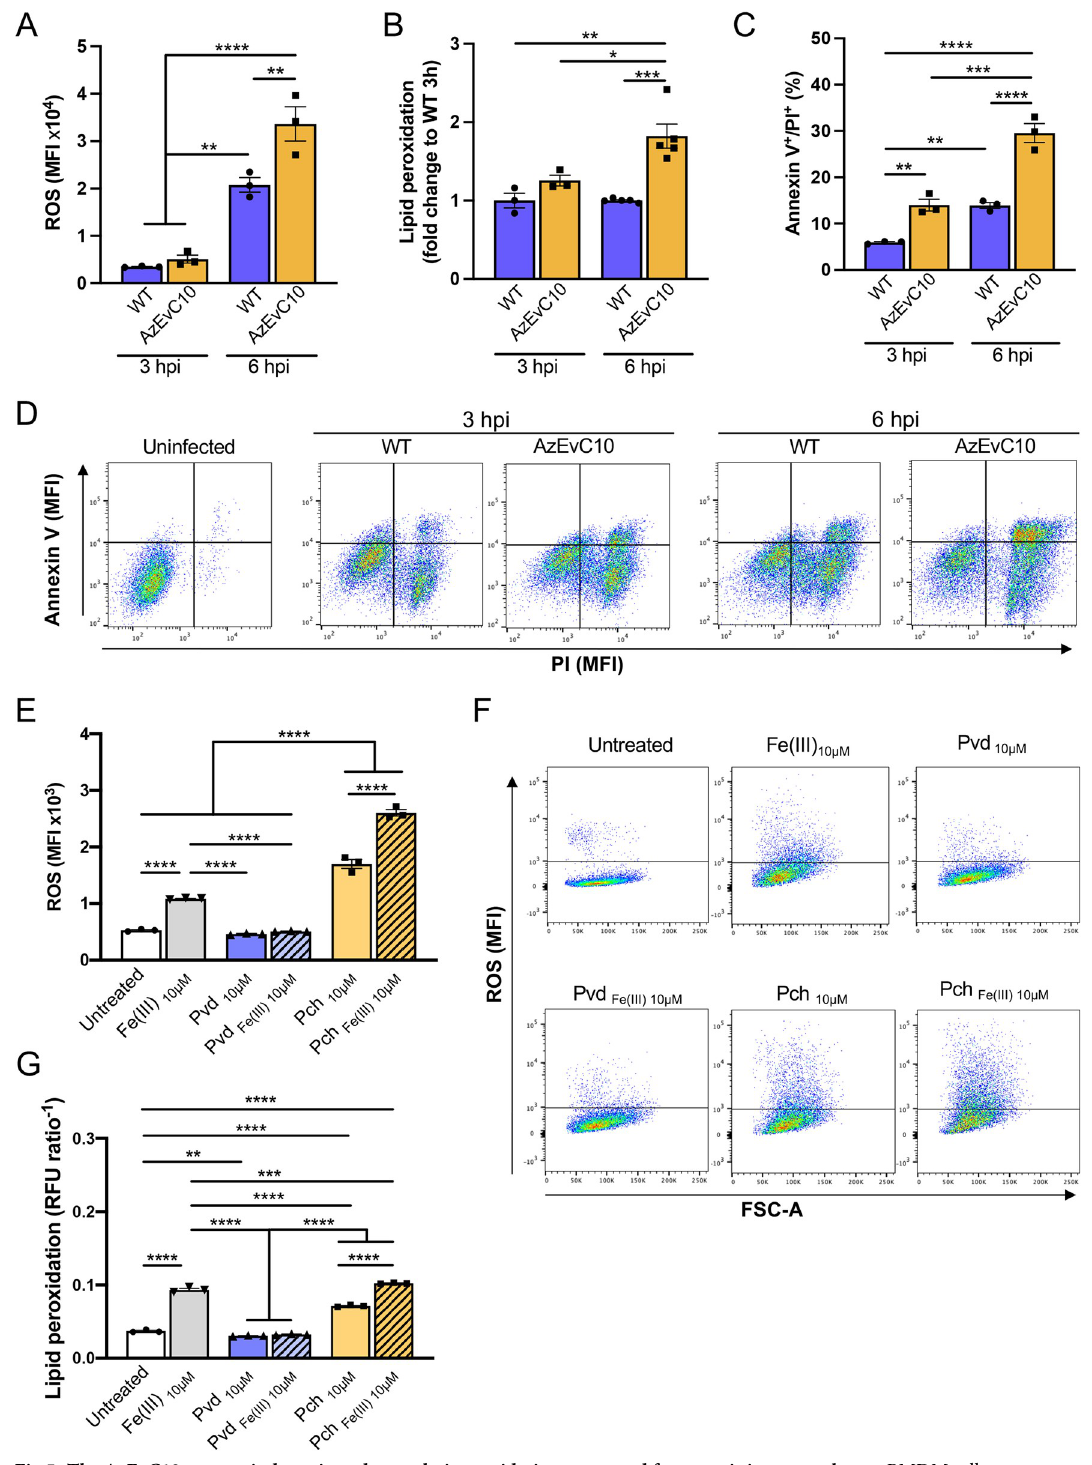
Fig 5. The AzEvC10 mutant induces iron dysregulation, oxidative stress, and ferroptosis in macrophages. BMDM cells were infected with WT PAO1 or AzEvC10 mutant at MOI:100 for 3 h and 6 h. A. Quantification of ROS in infected BMDM by flow cytometry. Quantification is presented in mean fluorescence intensity (MFI). Analysis was matched for experimental repeat. B. Quantification of lipid peroxidation in BMDM by flow cytometry presented as the reciprocal of the ratio of red (Ex561/Em582)/green (Ex488/Em525) fluorescence intensities normalized to WT PAO1 3 h. C-D. BMDM cell death was measured by flow cytometry and